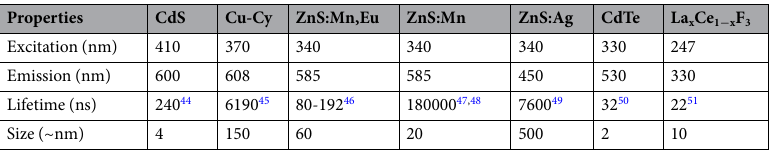
Table 1. The excitation, emission peak wavelengths and decay lifetimes of tested